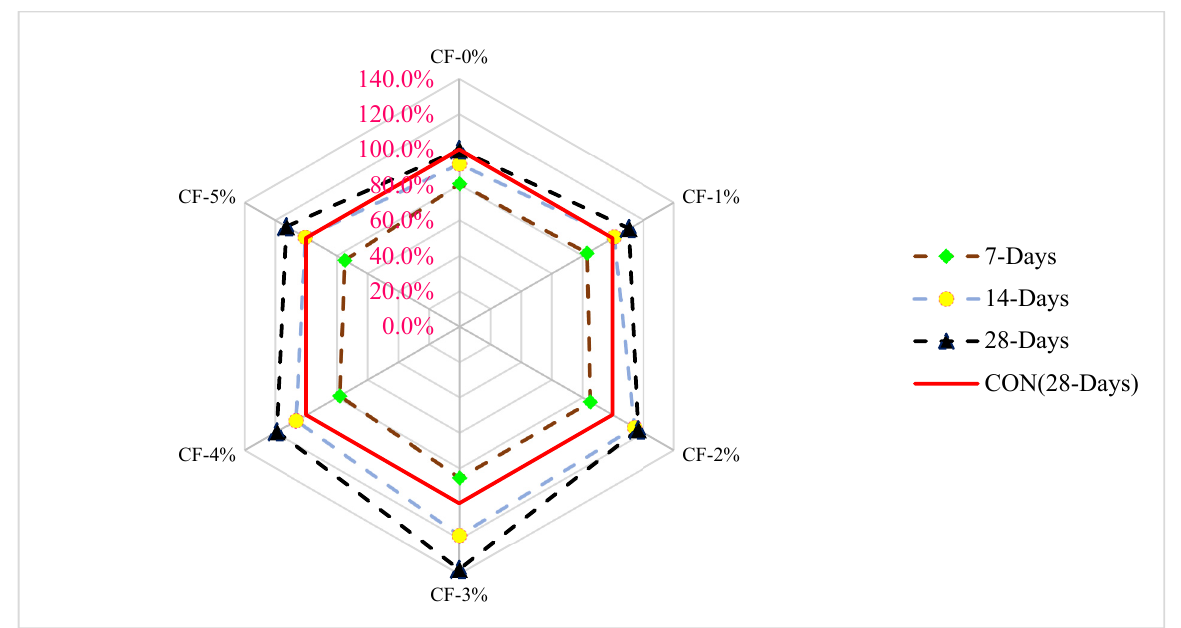
Figure 11. Relative analysis of flexure strength [24].